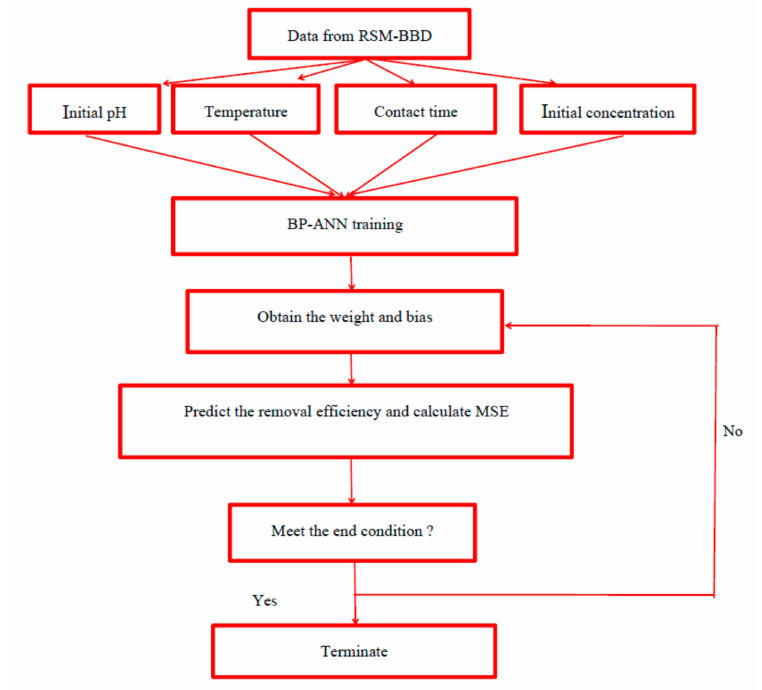
Figure 3. Flow diagram of BP-ANN